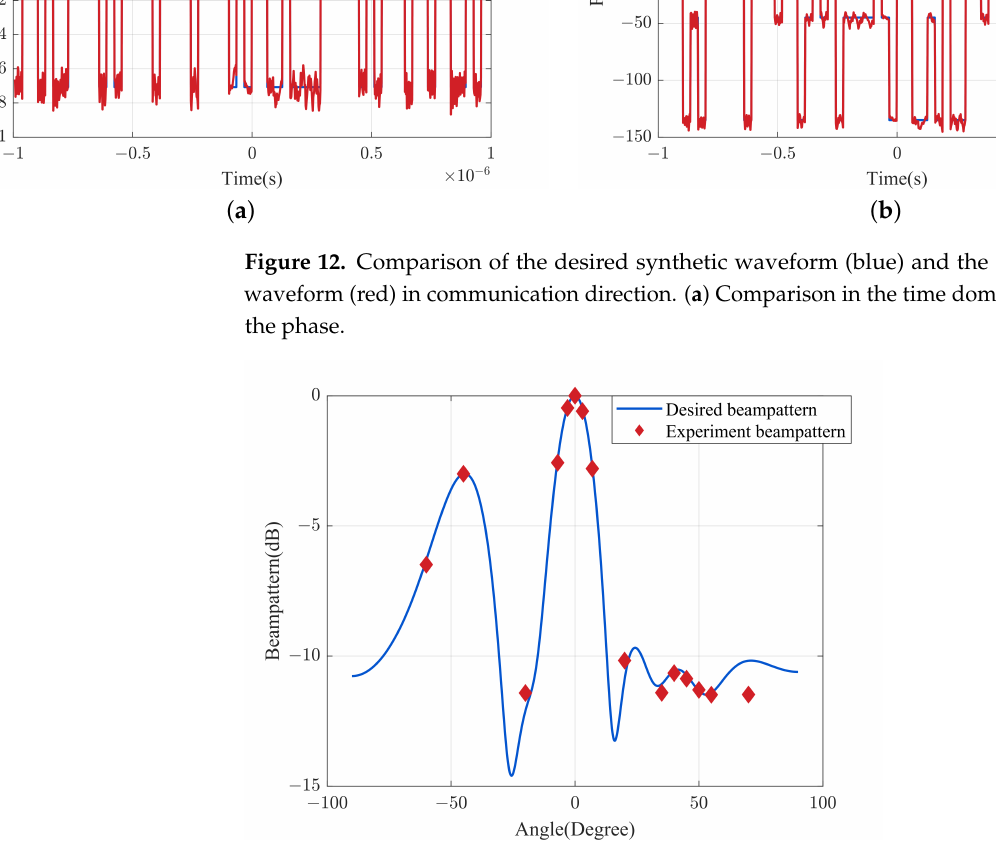
Figure 13. Comparison of the desired beampattern (blue) and the experimental beampattern (red).